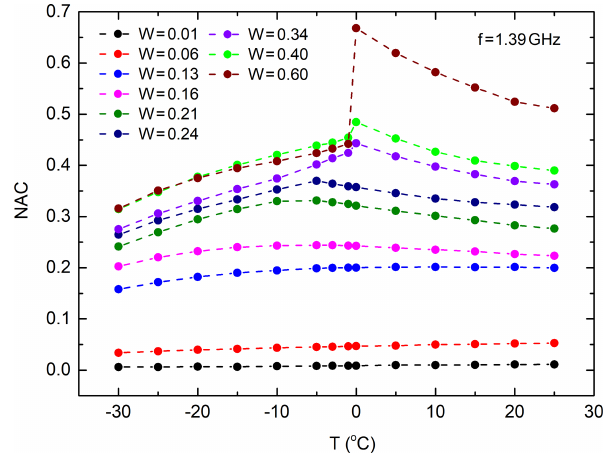
Figure 2. The spectra of the refractive index (RI) for sample no. 6 (TM) depending on the volumetric moisture content ( W ) of the soil sample at a temperature of T = 25 ◦ C. Volumetric moisture has di- mension W (cm 3 cm − 3 ) here and in other figures.